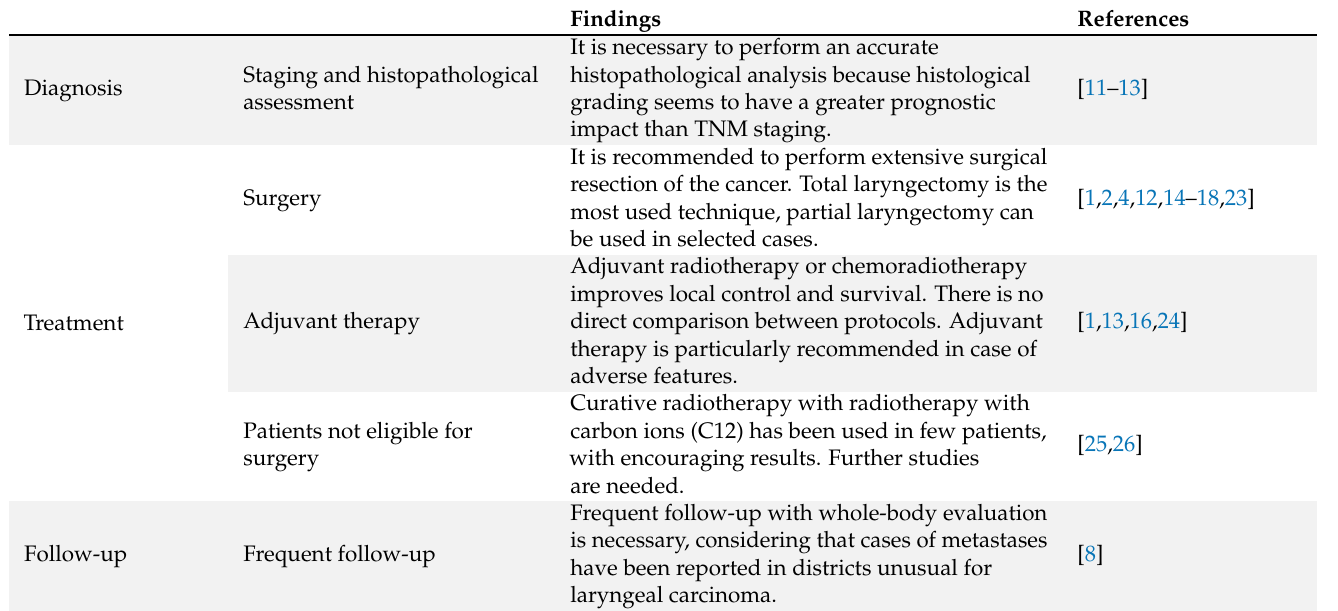
Table 2. LACC diagnosis and treatment protocol.